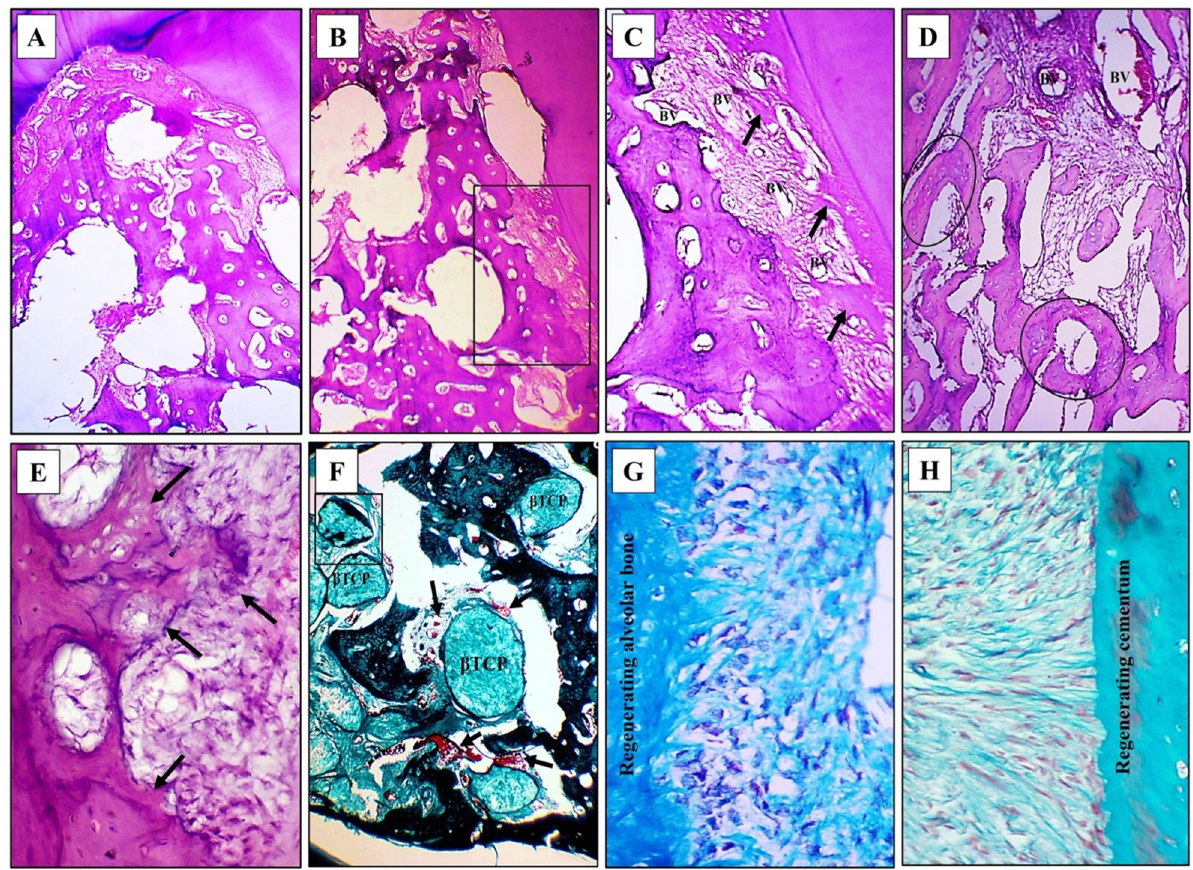
Figure 2. Experimental group at 4 weeks observational period (A,B) two successive images from one section revealing the formation of regenerative bone in wide areas of the defect with the formation of PDL fibers spanning the regions between the roots and the forming bone (insets), H&E, 40×. (C) Higher magnification of the two insets reveals the formation of PDL thin and irregular fibers spanning the distances between the roots and the forming bone. Note the homogeneous fiber patches (arrows) and the blood vessels among the regenerating irregular fibers (BV), H&E, 100×. (D) Formation of sheets of fibrous tissue between forming trabeculae and connecting them. These bone trabeculae consist partly of woven bone (circles), H&E, 100×. (E) Remodeling of the regenerating bone adjacent to the forming PDL (arrows), H&E, 100×. (F) Bone formation in close association with circular aggregates of β-TCP with accompanying rich blood supply (arrows), Trichrome stain, 100×. (G) Osteoblasts are arranged at the regenerating alveolar bone side and separated by the inserting fibers of the regenerating PDL, Trichrome stain, original magnification: 400×. (H) Cementoblasts are arranged in lines propagating perpendicular and in a radiating manner towards cementum and separated by inserting PDL fibers, Trichrome stain,